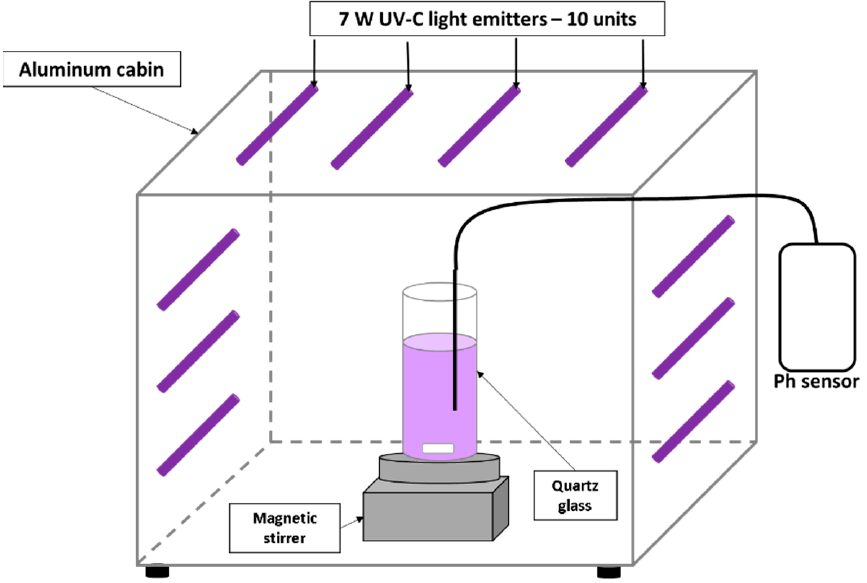
Figure 2. Experimental setup for photocatalytic dye degradation. Finally, discoloration blanks were performed on the wastewater solution using only hydrogen peroxide at the 10 mM concentration (oxidation), ilmenite at the load with the best color degradation (ilmenite catalysis), UV-C light radiation (photolysis), and ilmenite with ultraviolet light (photocatalysis without hydrogen peroxide) to compare their performance against the photocatalytic discoloration